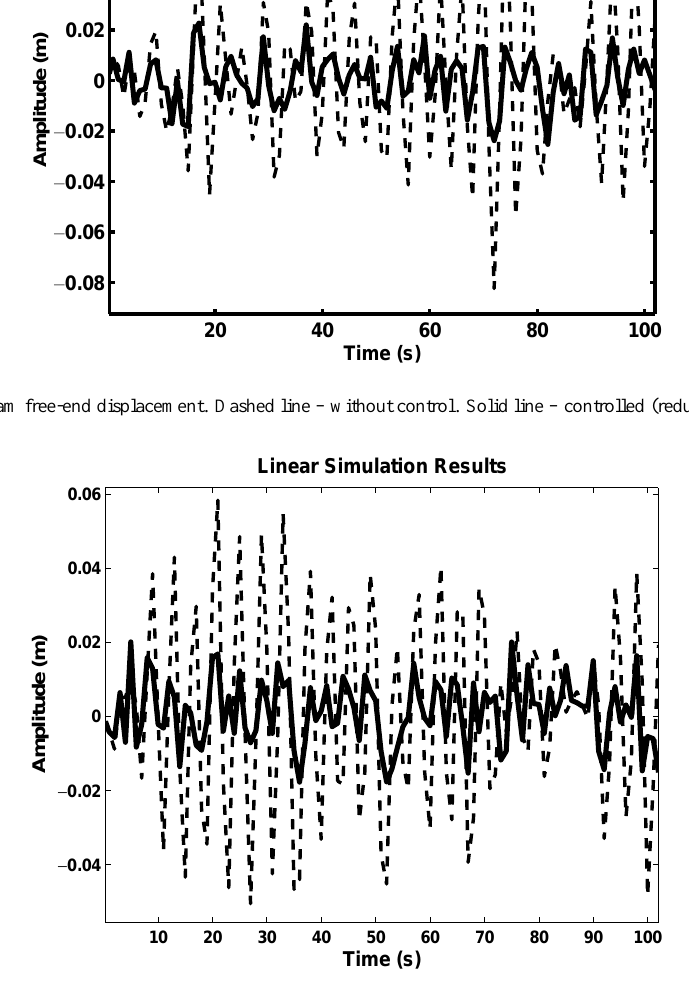
Fig. 9. Beam free-end displacement. Dashed line – without control. Solid line – controlled (full